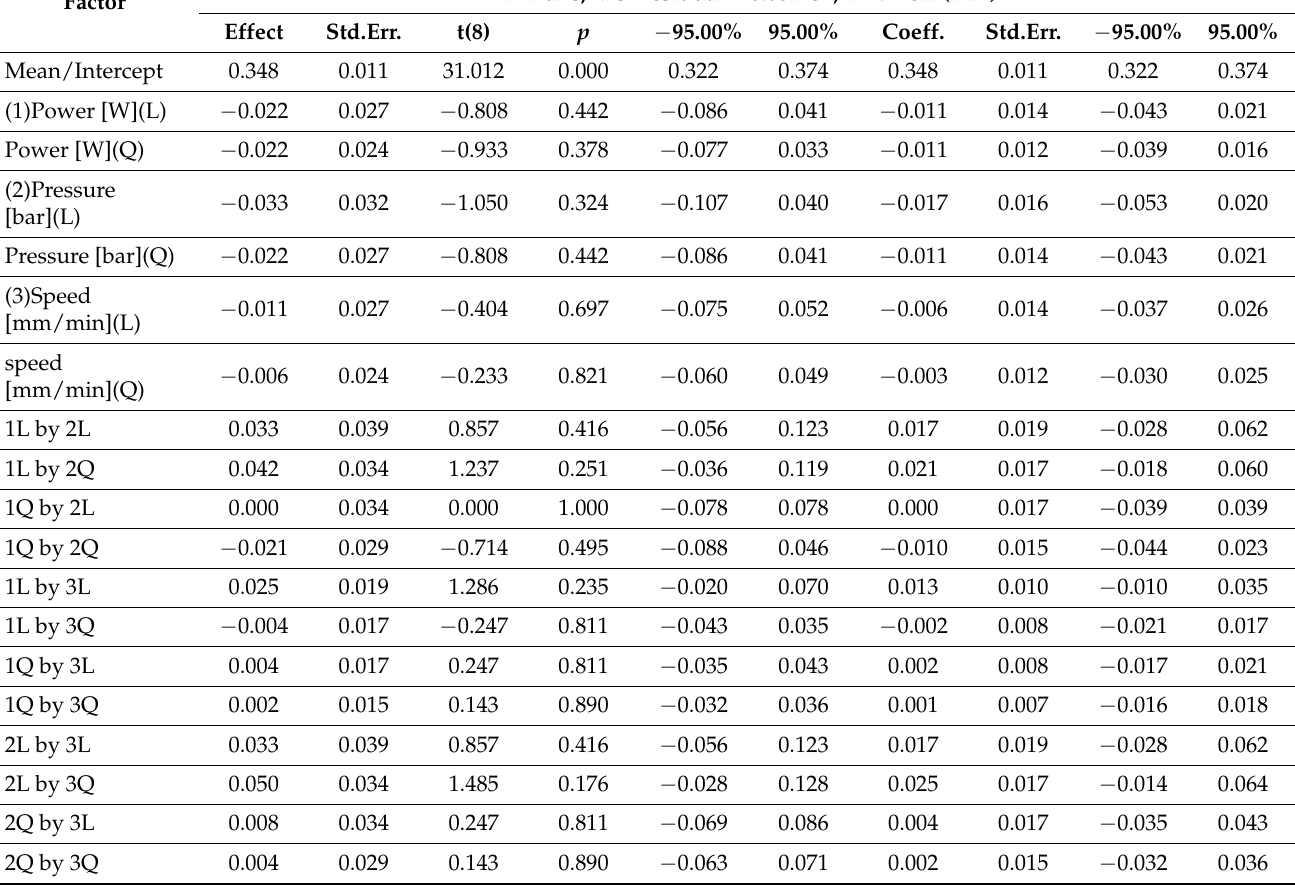
From Table 7 provided by the Statistics 7.0 program results: the coefficient of determi- nation R 2 = 0.74211, the adjustment coefficient Adj = 0.16184 and the standard deviation STD = 0.01122. The average cutting width is 0.348 mm resulting from a complete factorial experiment with 27 trials. There is a 7421% chance that the influencing factors and their interactions will determine the cutting width. The adjustment coefficient helps to